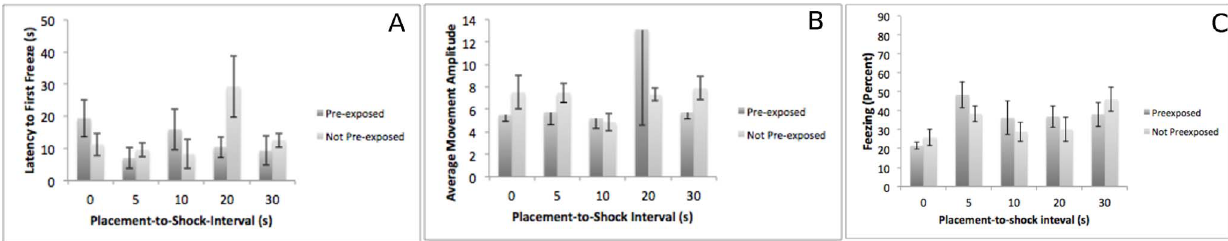
Figure 1. The results of Experiment 1–1 – contextual fear conditioning at PD 17/18/19. Subjects pre-exposed (dark bars) or not pre- exposed (light bars) to the conditioning context on day 1 do not differ in their latency to freeze (Panel A), their initial movement amplitude (Panel B) or in their freezing (Panel C) on test day.